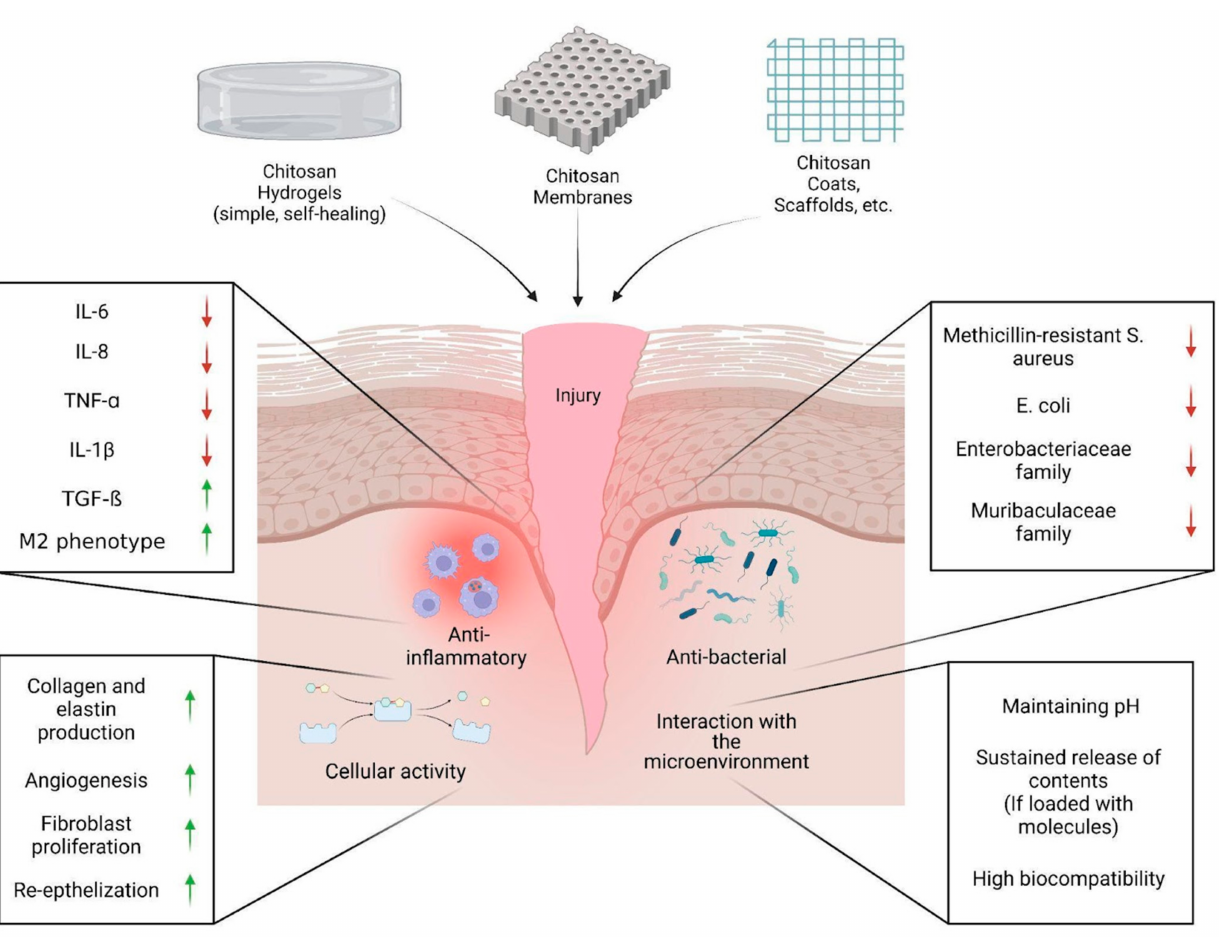
Figure 2. The effect of applying different chitosan biomaterial forms on skin injury. Various forms of chitosan-based materials are studied for the treatment of skin lesions, including hydrogels, mem- branes, topical gels, sponges, etc. Due to the physico-chemical properties of chitosan those biomateri- als work at all stages of wound healing, enhancing skin repair, decreasing fibrosis and promoting anti-inflammatory, antibacterial, and cell proliferative